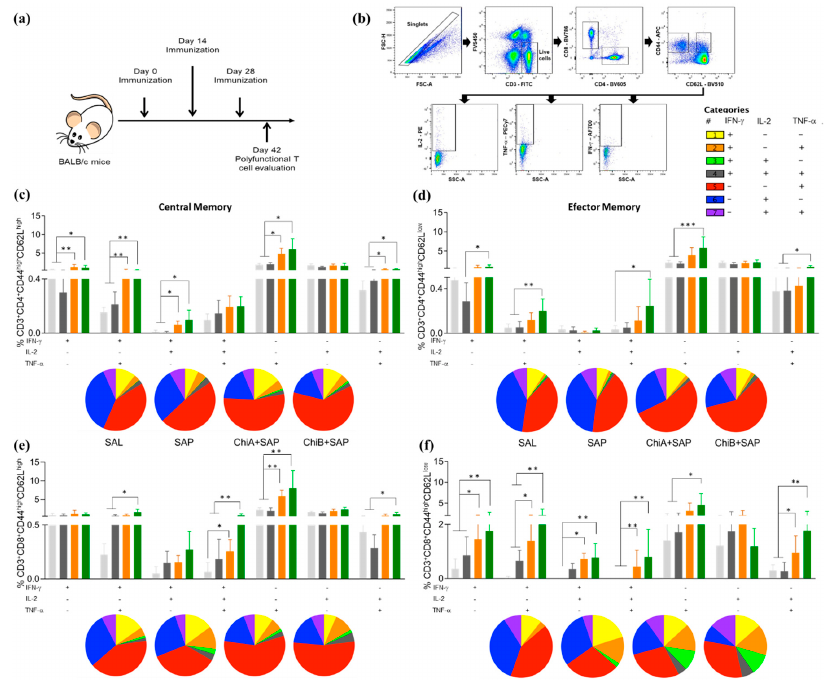
Figure 3. Percentage of polyfunctional T cells in spleens of immunized mice with ChiA + SAP (animals that received 10 µ g of the chimeric protein A associated with 60 µ g of saponin) and ChiB + SAP (animals inoculated with 10 µ g of chimeric protein B associated with 60 µ g of saponin). Polyfunctional T cells were evaluated by percentage of intracellular IL-2, TNF- α , and IFN- γ producing T cells (central and e ff ector memory) at the same time. ( a ) BALB / c mice were immunized three times and polyfunctional T cells were assessed in spleen 14 days after the last immunization using multicolor flow cytometry. ( b ) Representative plot of the gating strategy to characterize the multifunctional T cell producers of intracellular IFN- γ , TNF- α, and IL-2 using the Boolean gate strategy. ( c ) The percentage of CD3 + CD4 + CD44 high CD62L high and ( d ) CD3 + CD4 + CD44 high CD62L low cells producing single, double, and triple cytokines after in vitro stimulation with SLA (soluble Leishmania antigen). ( e ) The percentage of CD3 + CD8 + CD44 high CD62L high and ( f ) CD3 + CD8 + CD44 high CD62L low producing single, double, and triple cytokines in vitro after stimulation with SLA. The groups SAL (animals that received sterile saline, 0.9% NaCl, pH 7.2–7.4), SAP (animals inoculated with 60 μ g of saponin), ChiA+SAP, and ChiB+SAP are represented by the colors light grey, dark grey, orange, and green, respectively, and pizza graphs represent the pattern of cytokine production. Data are expressed as means plus/minus standard deviation of two independent experiments ( n = 8). Significant differences between the groups are represented by p- values: * p-value < 0.05, ** p-value < 0.005, *** p-value < 0.0005. 3.4. Chimeras a and B Not Only Induced Proliferation of T Cells but Also Enhanced the Production of Intracellular Cytokines by These Cells in the Spleen of Immunized Mice and after Being Challenged with L. Infantum